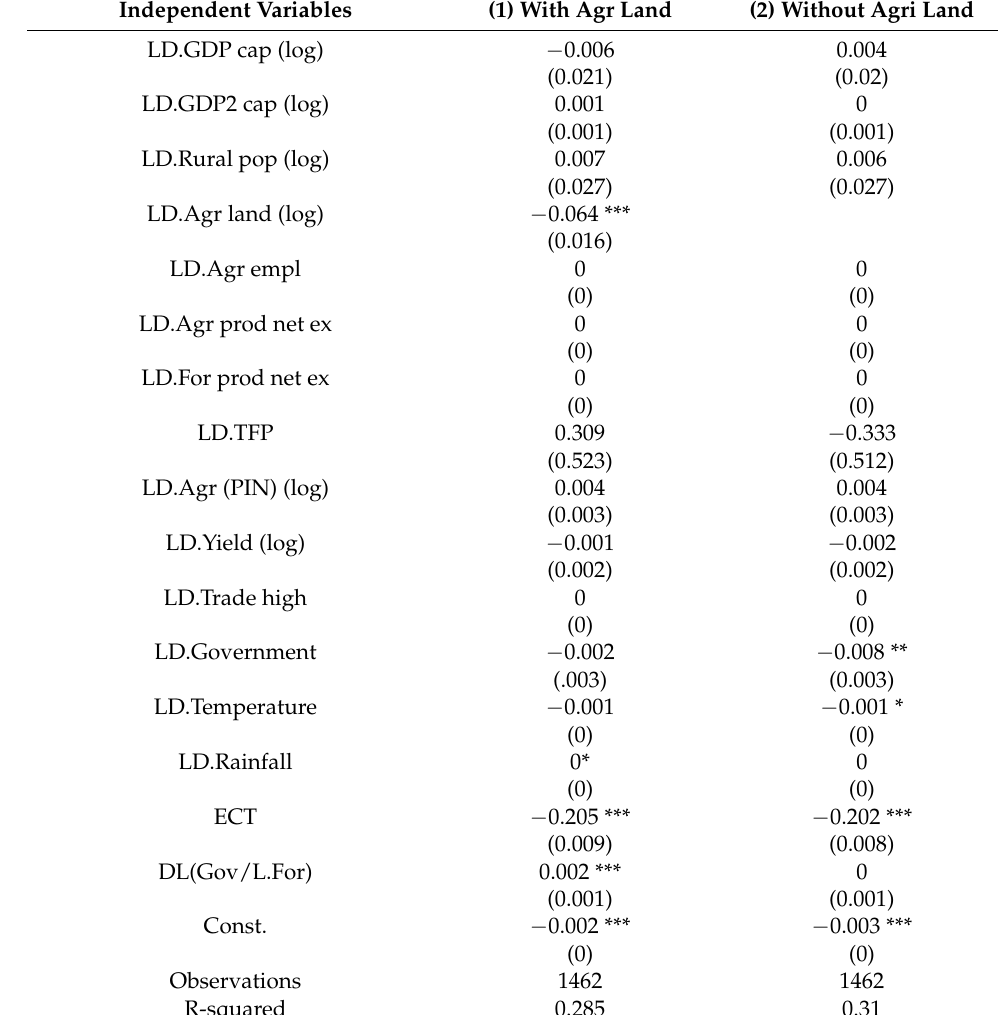
Table 9. Short-run equations, all countries.